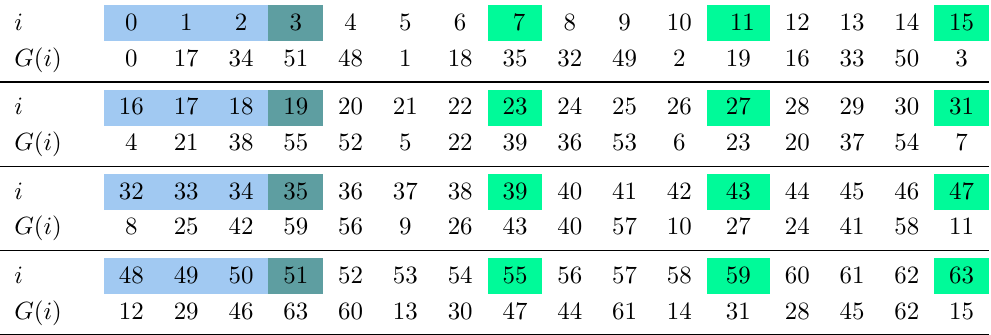
Table 8: Specifications of GIFT bit-permutation